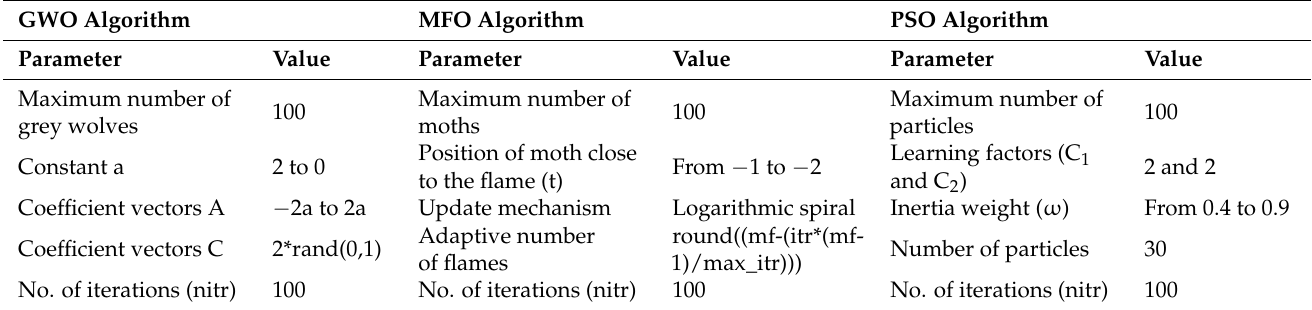
Table 12. Algorithm parameters for GWO, MFO, and PSO algorithms.